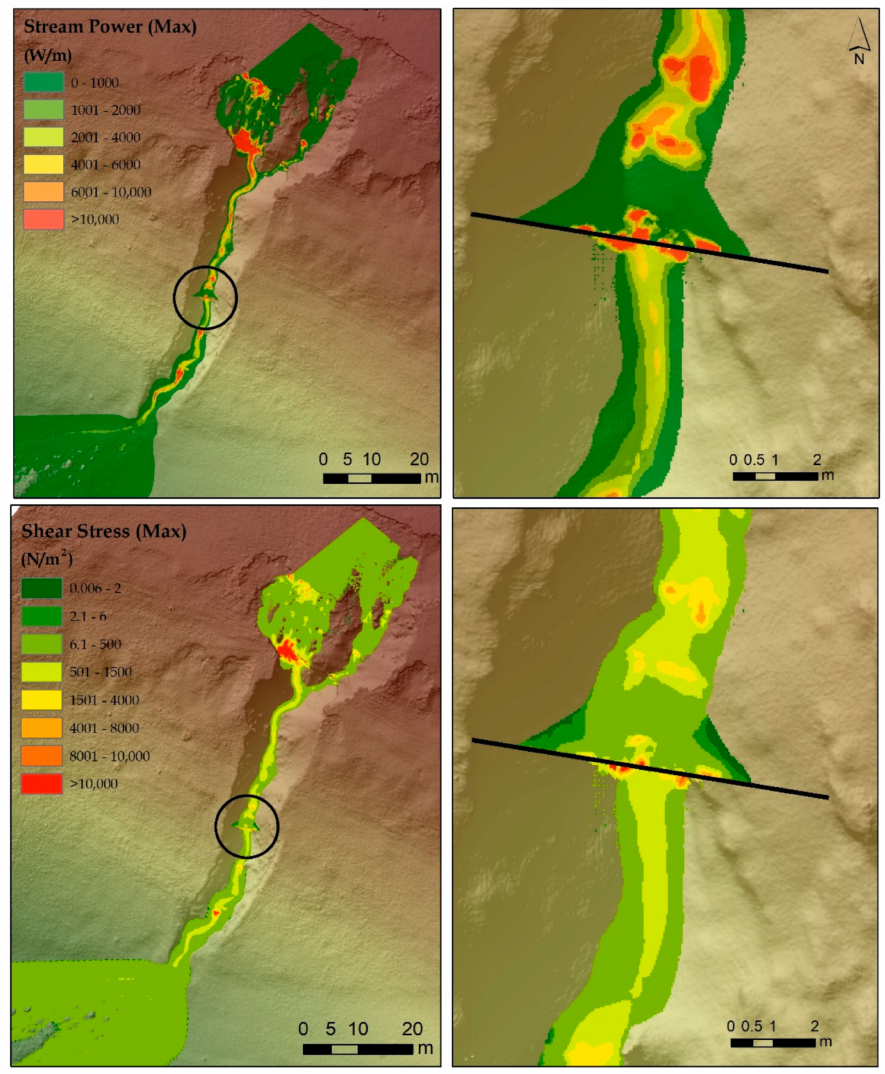
Figure 14. Results of simulation